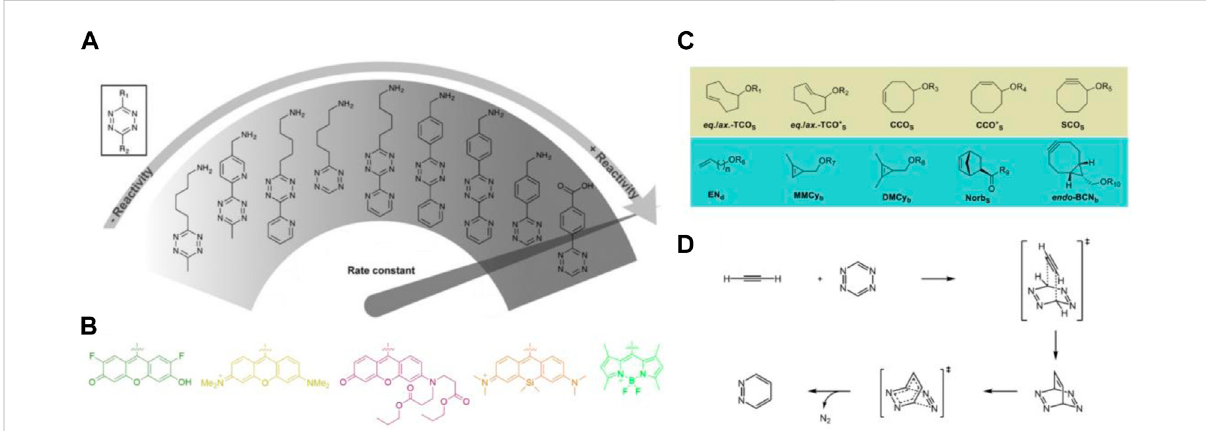
FIGURE 1 General information of the building blocks applied in TBC. (A) Reactivity of selected tetrazines in Diels-Alder cycloaddition. (B) Selected fl uorescereporterontetrazinemotifwithoff/onmechanism. (C) CommonlyutilizeddienophilesinDiels-Aldercycloaddition. (D) Mechanismsofthe Diels-Alder